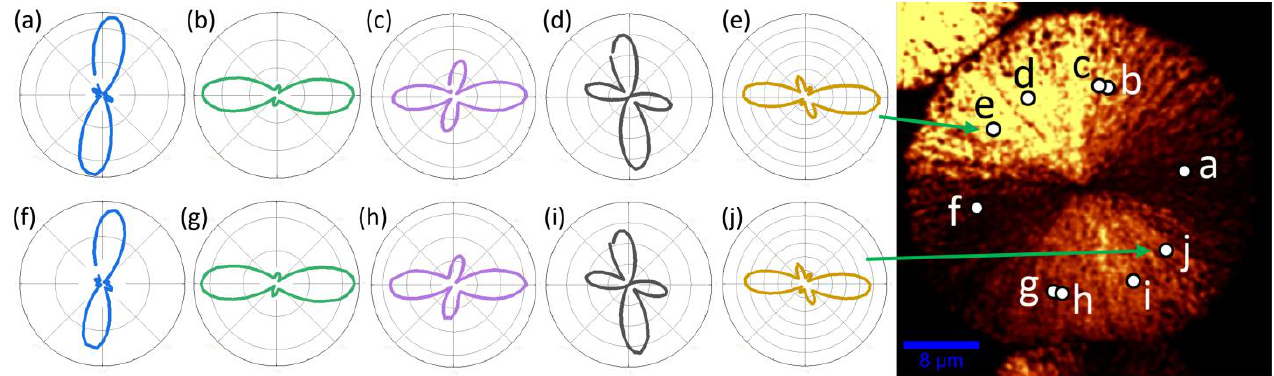
Figure 6. Experimental azimuthal dependencies of the SHG intensity in the regions of spherulite number six, the polar coordinate of which differs by 180° (In one row ( a – e ) five random different regions on the spherulite, in the second row ( f – j ) the corresponding opposite regions). The image on the right illustrates the location of the local regions. Silicon substrate.